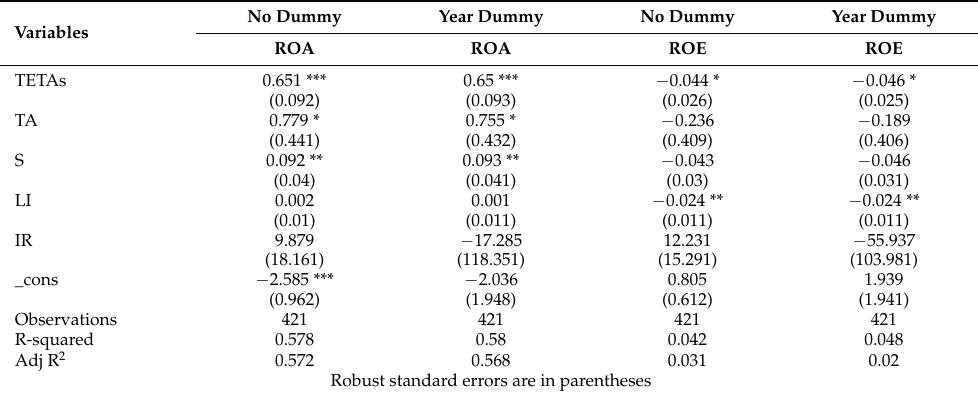
Table 8. Results of the Effects of TETAs on ROA and ROE, as per OLS Regression.